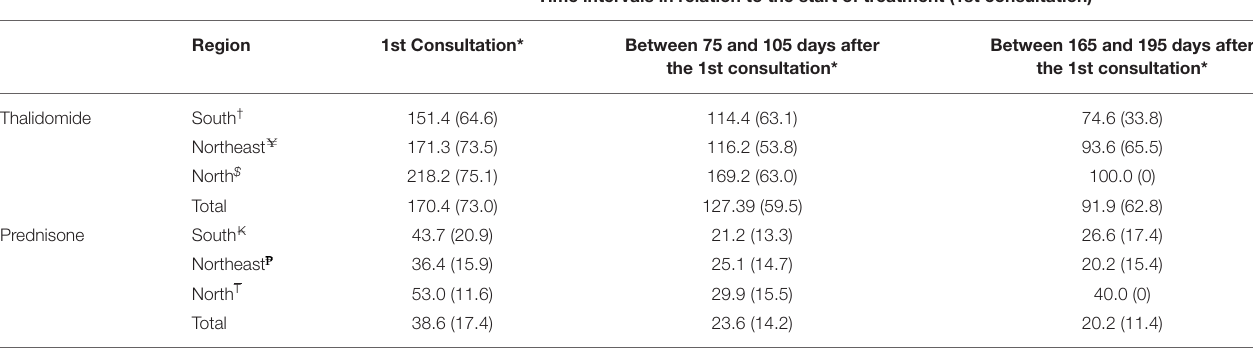
TABLE 3 | Average doses of medications by region and selected treatment periods. Time intervals in relation to the start of treatment (1st consultation) Region 1st Consultation* Between 75 and 105 days after Between 165 and 195 days after the 1st consultation* the 1st